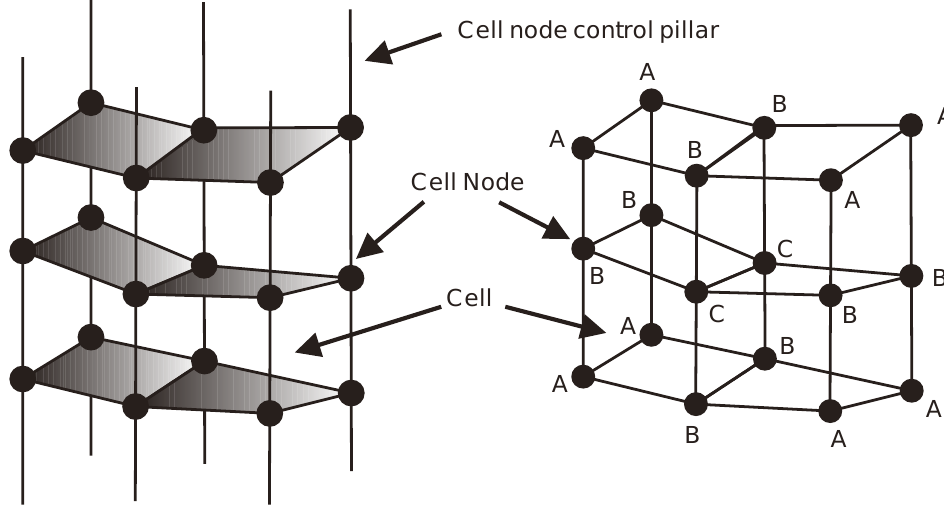
Figure 3. Indexing mode of hexahedral CP grids.